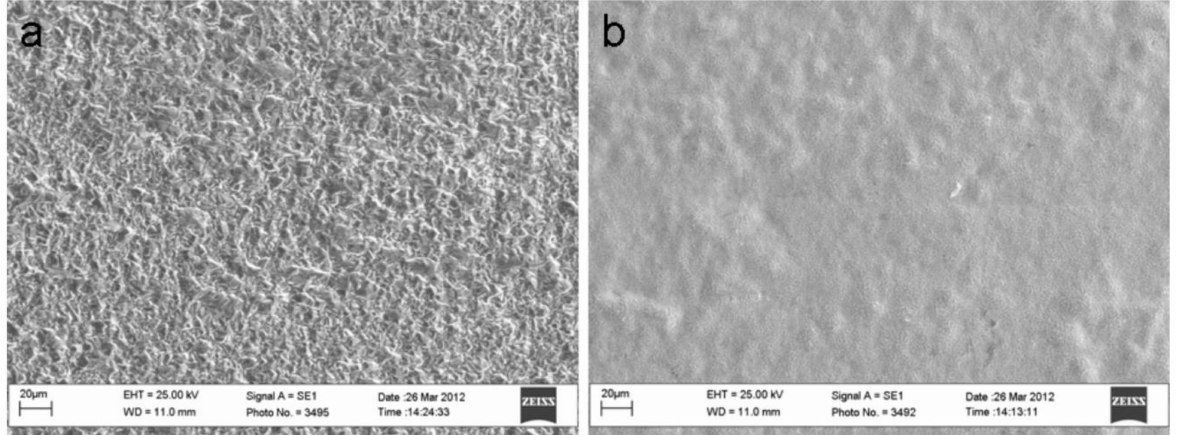
Figure 8. SEM images of the copper electrode obtained by cathodic deposition of copper from an aqueous CuSO 4 solution before ( a ) and after ( b ) electropolishing in BmimNTf 2 (reprinted with permission from ref. [15]; Copyright 2013 American Chemical Society).